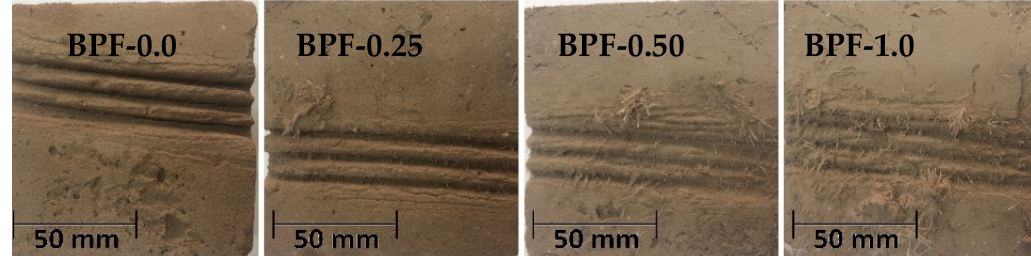
Figure 15. Representative images of the dry abrasion resistance of each earthen mix.